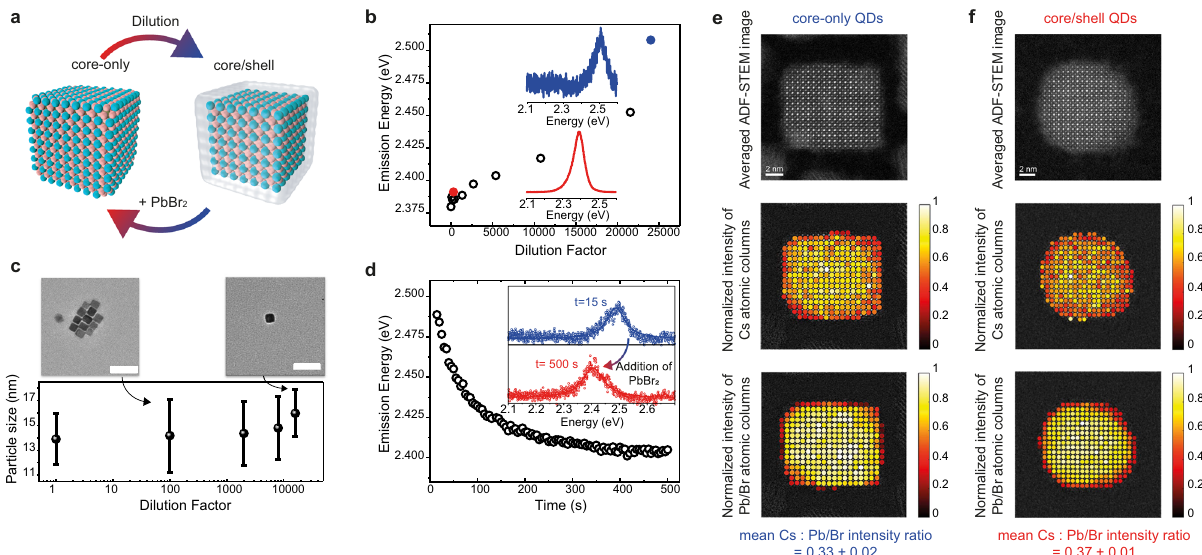
Fig. 3 Dilution-induced surface modi fi cation of CsPbBr 3 QDs. a A sketch of the core/shell formation during dilution and its reversibility. b Peak emission energy of QD dispersions upon progressive dilution (circle points). For a small (red solid marker) and a high dilution factor (blue solid marker), respectively, the insets show the corresponding PL spectra. c TEM analysis of particle size distribution at different dilution steps. Error bars represent the standard deviation of the size distribution obtained by measuring particle sizes for ca. hundred different QDs from the same batch. Two representative TEM images are also displayed (scale bar = 50 nm). d Addition of PbBr 2 to the QD solution redshifts, within several tens of seconds, the emission energy towards the original values before dilution (black open circles). Inset shows PL spectra at the beginning and after 500 s. e , f Typical ADF-STEM images of a core-only QD ( e ) and a core/shell QD ( f ) obtained through aligning and averaging their respective image series consisting of 10 frames (1024 × 1024, 1 µ s dwell time); fi t of the intensities of the Cs (middle plots) and Pb/Br atomic columns (lower plots) plotted at the fi tted coordinates. For the sake of clarity and comparability, the fi tted intensities of each QD are normalized to the maximum atomic column intensity. The analysis reveals that the core/shell QDs (see SI for additional examples) feature an amorphous, 1-nm-thick shell and a more spherical shape than original QDs. Additionally, the mean Cs:Pb/Br intensity ratio of the crystalline region of all studied QDs increases from 0.33 ± 0.02 in core-only QDs to 0.37 ± 0.01 in core/shell QDs, due to the leaching of Pb and Br ions upon dilution (errors denote the standard (see Supplementary Fig. 1), these QDs exhibit an ensemble PL (FWHM = 73 meV, Fig. 1c).